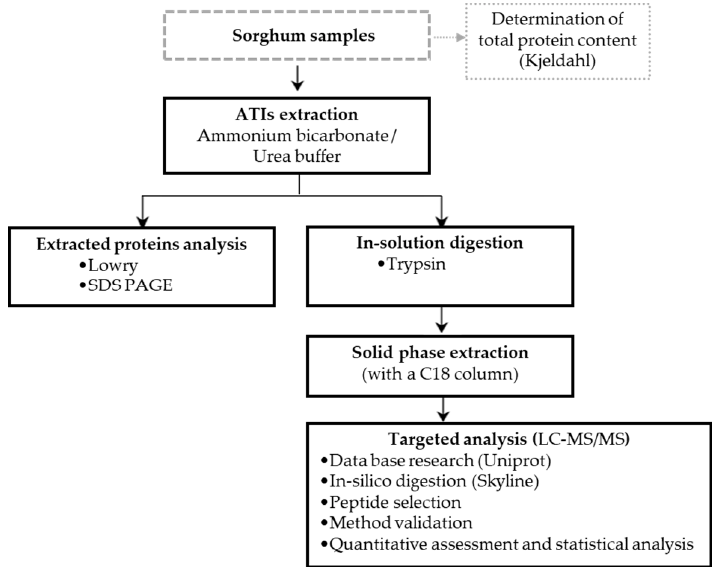
Figure 5. Workflow showing the different processing steps and the analytical methods.